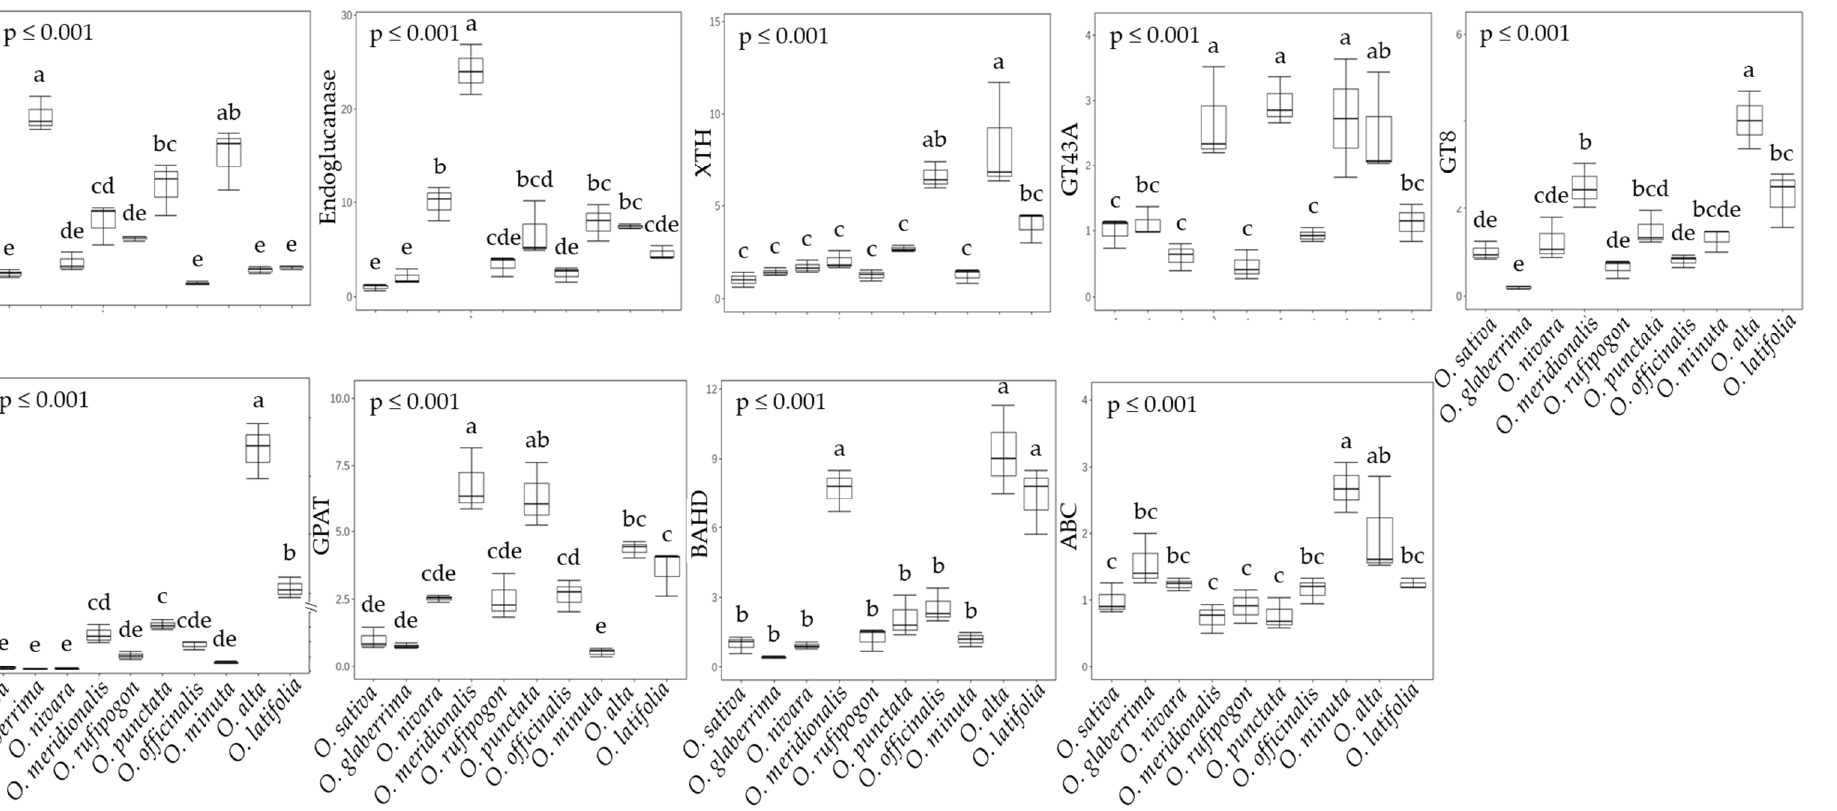
Figure 6. Comparison of relative gene expression encoding several major enzymes associated with primary (top) and secondary (bottom) cell wall synthesis between wild rice species at 60 DAT (mean of three replications ± S.D.). Means followed by different letters in the same raw are significantly different at p < 0.05 according to Tukey’s HSD test. CslC, cellulose-synthase-like C; Endoglucanase; XTH, endotransglucosylase/hydrolase; GT43A, glycosyltransferase; GT8, glycosyltransferase; FAR, fatty acyl reductase; GPAT, glycerol-3-P acyltransferase; BAHD, BAHD acyltransferase; ABC, ATP-binding cassette transporter.